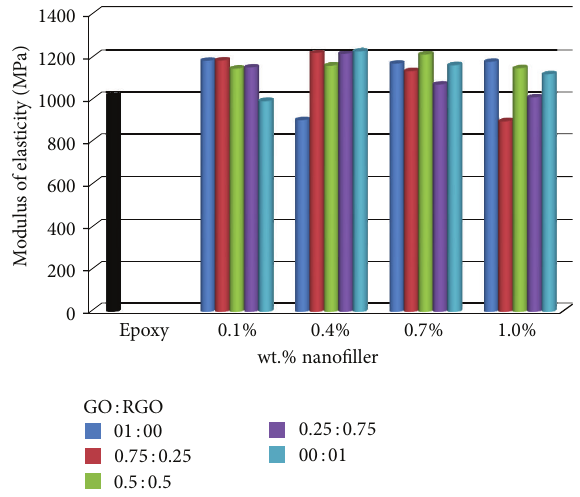
Figure 6: Modulus of elasticity of nanocomposites reinforced with nanomaterials.